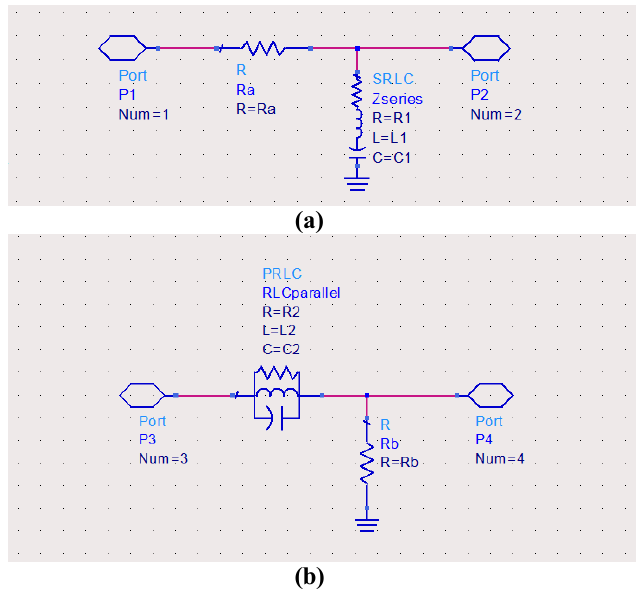
(b) FIGURE 2. ADS® schematic of designed (a) RLC-series and (b) RLC-parallel circuits. TABLE II. Components Used to Design the RLC-Series and RLC-Parallel Circuits Function Type Parameters Values